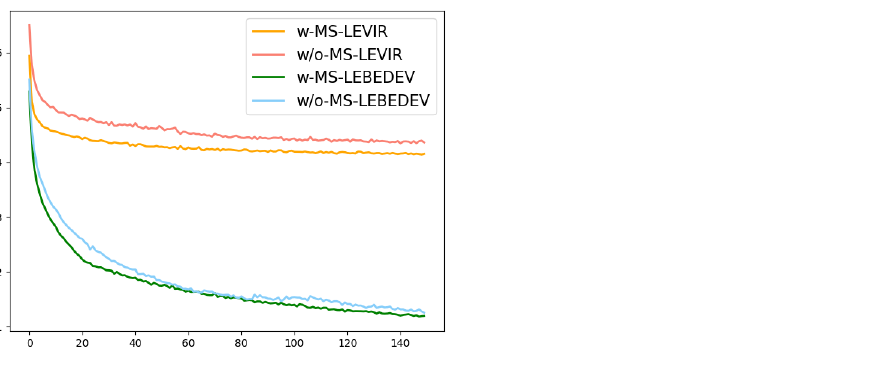
Figure 12. Ablation study on training losses with/without multilevel supervision (presented as ‘MS’) of